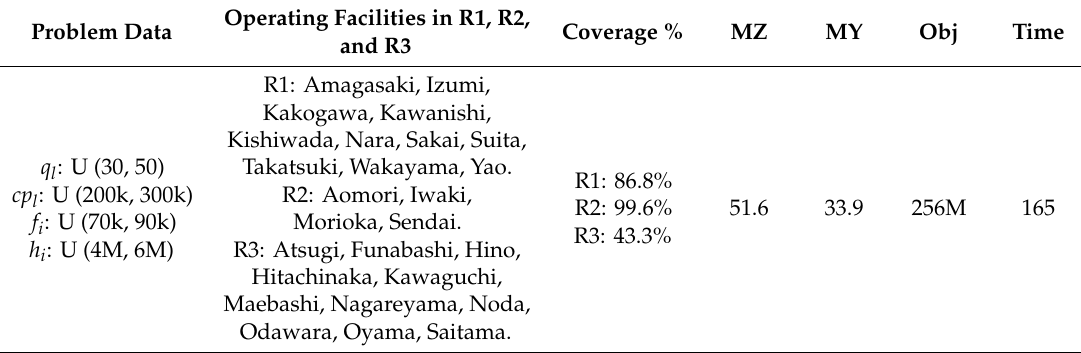
Table 2. Computational results of case study and sensitivity analysis.